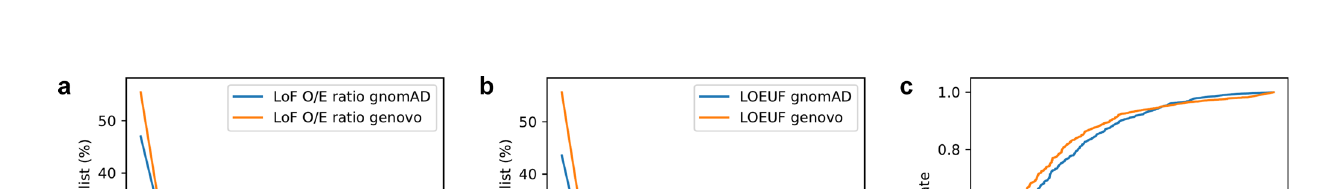
numberusingGenovoanddenovolyzeR. b Pearsoncorrelationcoef fi cientbetween the observed number of mutations per coding position and the expected number per coding position for each gene using Genovo and denovolyzeR.